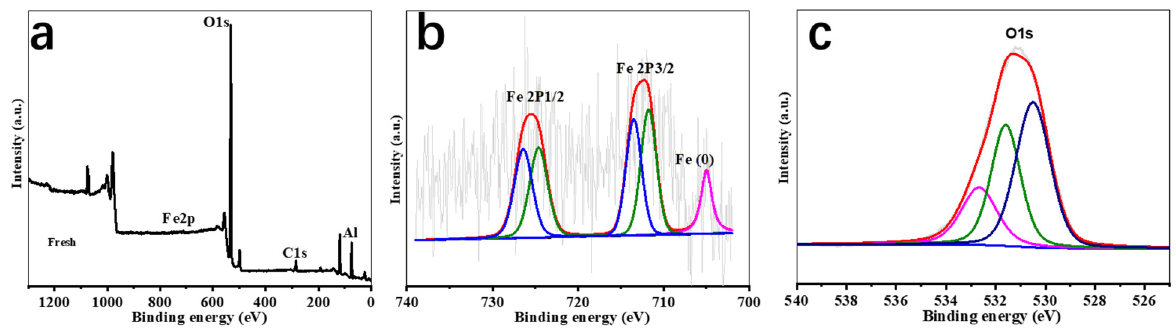
Figure 5. XPS spectra of ZVI-ALOX before the Cr(VI) removal reaction: ( a ) wide scan survey spectrum; ( b , c ) high resolution spectra of Fe 2p and O1s.